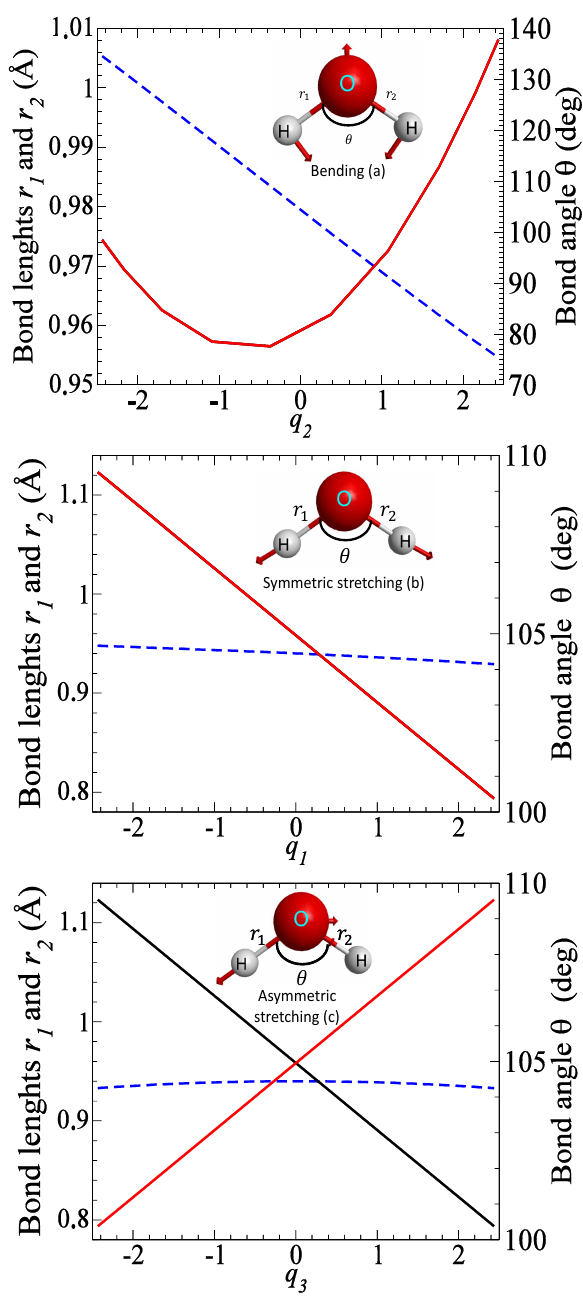
Figure 2. Normal modes of H 2 O. The figure shows the dependence of inter-particle distances r 1 , r 2 and the bond angle θ as functions of normal mode coordinates: ( a ) bending, ( b ) symmetric stretching and ( c ) asymmetric stretching. The arrows indicate the direction and magnitude of displacements for each mode. Bond lengths are given with solid lines with values on the left axis, while the bond angle is given with a dashed line with values on the right axis of each panel. Note that the curves of the bond lengths r 1 (black) and r 2 (red) are indistinguishable for the bending and symmetric stretching